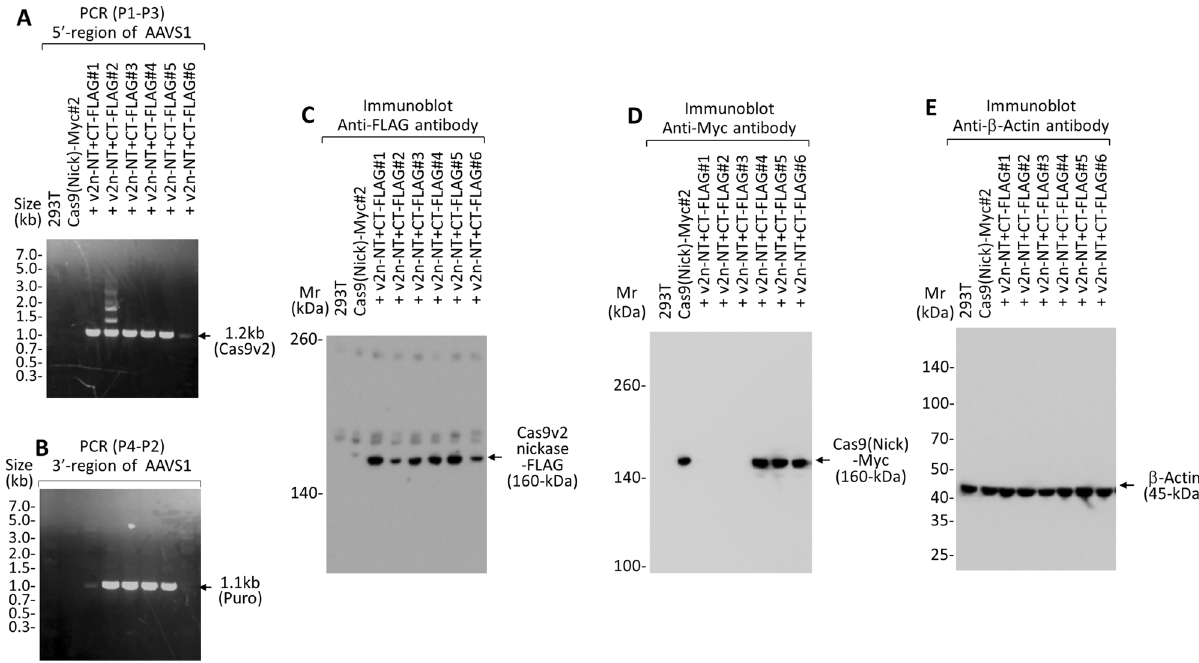
Figure 9. PCR and immunoblot analysis to confirm the reconstitution of full-length Cas9v2nickase-FLAG in the AAVS1 locus. ( A , B ) PCR analysis of genomic DNA prepared from HEK293T, HEK293T-Cas9(Nick)-Myc, and HEK293T-Cas9(Nick)-Myc + v2n-NT + CT-FLAG #1–#6 cells, after sequential infections of AAV vectors #7 and #8, as in Fig. 8A. v2n-NT, 1.9 kb Cas9v2 nickase-NT; CT-FLAG, 2.3 kb Cas9v2-CT-FLAG. Primers P1–P3 (Cas9v2), and P4–P2 (Puro), were used to examine the integration efficiency of the reconstituted full-length Cas9v2nickase-FLAG into the AAVS1 locus at the 5 ′ - and 3 ′ -regions. ( C – E ) Lysates obtained from the same cells used for the PCR analysis were analyzed using immunoblot, with the antibodies indicated. Arrows indicate reconstituted full-length Cas9v2nickase-FLAG (160 kDa), lentiviral Cas9 (Nick)-Myc (160 kDa), and β-actin (45